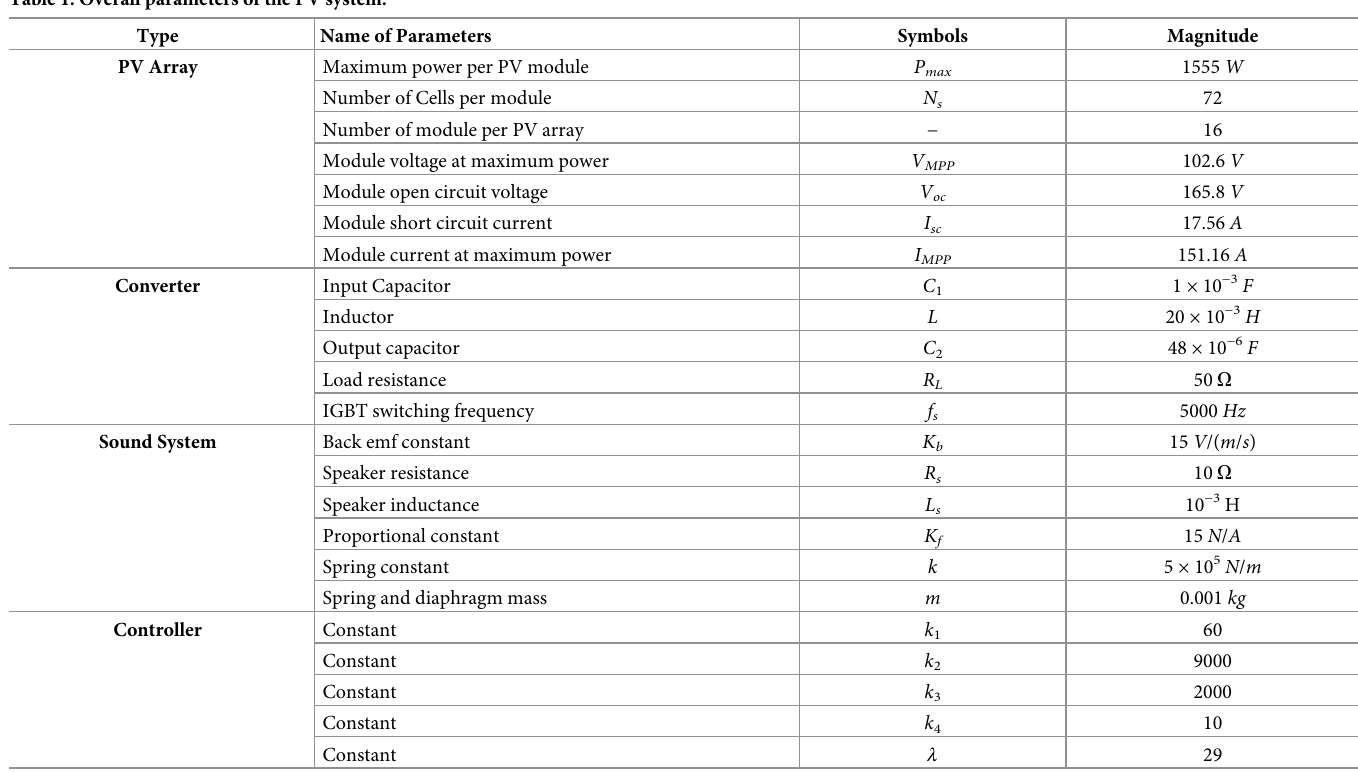
Table 1. Overall parameters of the PV